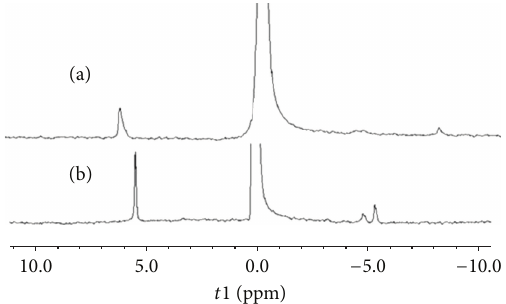
Figure 11: 31 P NMR of the residues after combustion of: (a) flame- retarded PA6 with ADPP/ME; (b) flame-retarded PA6 with ADPP,